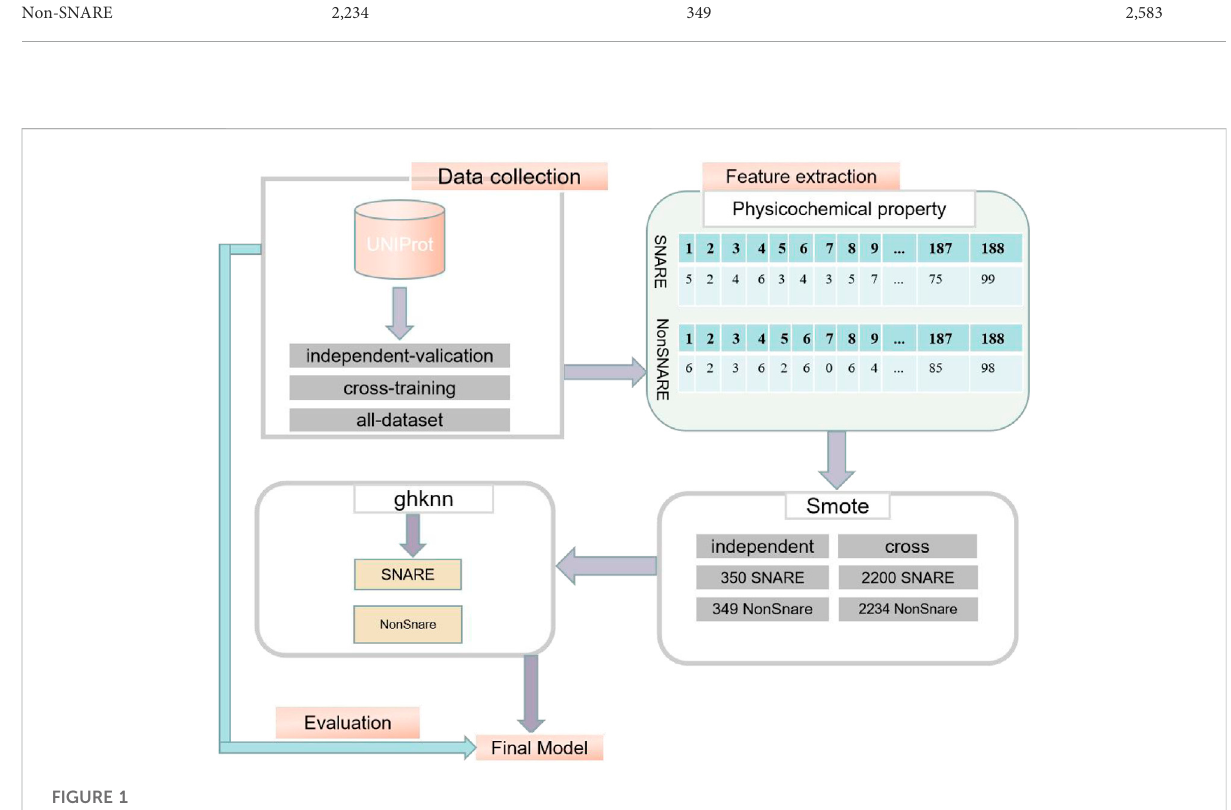
FIGURE 1 Experimental procedure